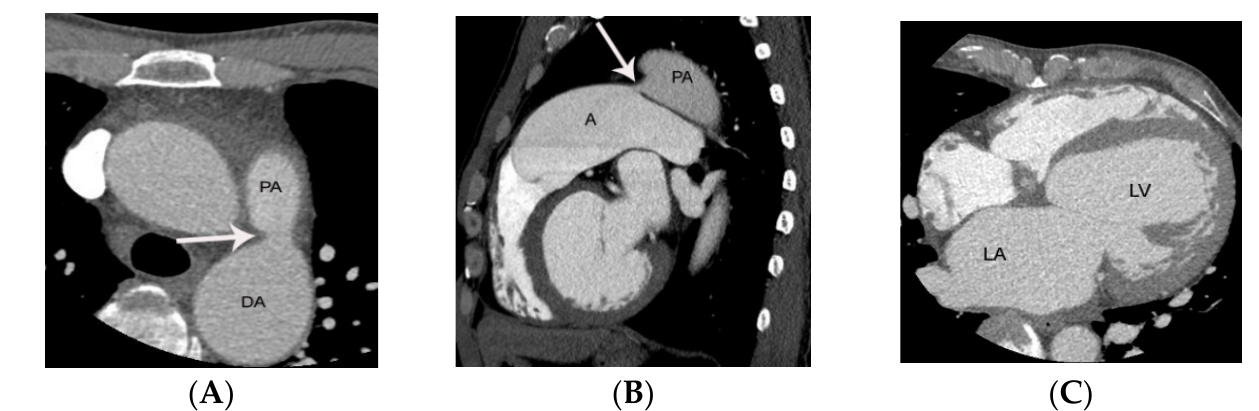
Figure 8. PDA diagnosed initially by ECG-gated cardiac CT, leading to closure with Amplatzer duct occluder in a 46-year-old male patient who presented with dyspnea. Conically shaped PDA without valve-like structure at the pulmonic end is noted on axial (arrow on A ) and sagittal (arrow on B ) CT images. Left atrial and ventricular enlargement is demonstrated on an axial CT image at the level of the left ventricle ( C ). PDA closure by Amplatzer duct occluder was performed in this patient due to left atrial enlargement (dyspnea). ECG-gated cardiac CT angiography provided excellent anatomic detail and planimetry without motion artifact prior to PDA closure. DA, PA, LA, and LV indicate descending thoracic aorta, pulmonary artery, left atrium, and left ventricle,